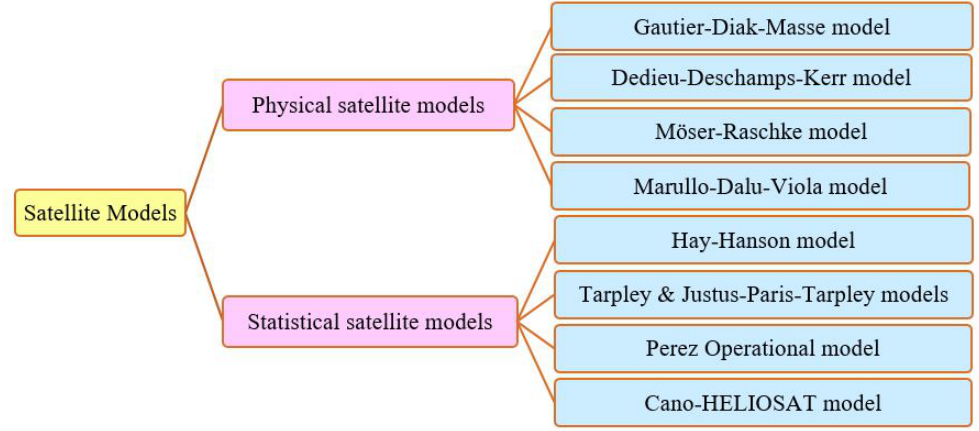
Figure 4. Classification of satellite-based forecasting models